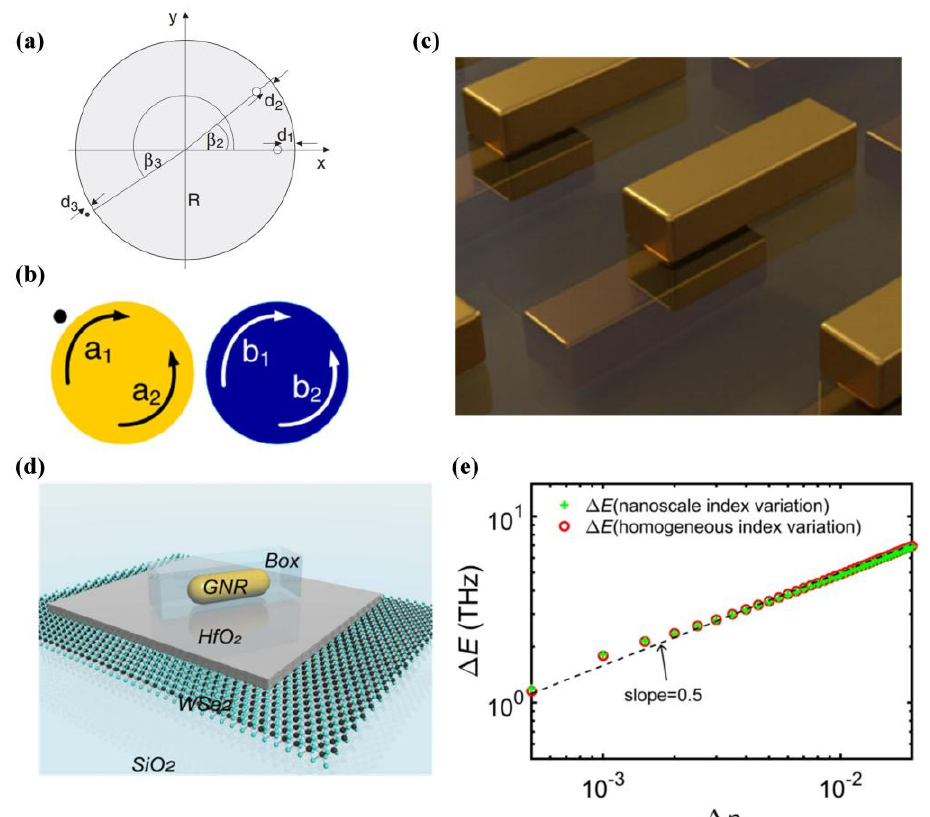
Figure 9. ( a ) The WGM resonator. Adapted with permission from Ref. [137]. Copyright (2016), American Physical Society. ( b ) Two–coupled WGM resonator. Adapted with permission from Ref. [141]. Copyright (2018), Chinese Laser Press. ( c ) Schematic of a bilayer periodic plasmonic structure composed of two optically dissimilar plasmonic resonator arrays with detuned resonances. Adapted with permission from Ref. [147]. ( d ) Schematic of nanoscale sensing of the environmental RI variation within the box region surrounding the GNR. Adapted with permission from Ref. [50]. Copyright (2022), Chinese Laser Press. ( e ) Absolute value variation in the eigenvalue difference between the hybrid modes of the plasmon–exciton sensor in response to environmental RI